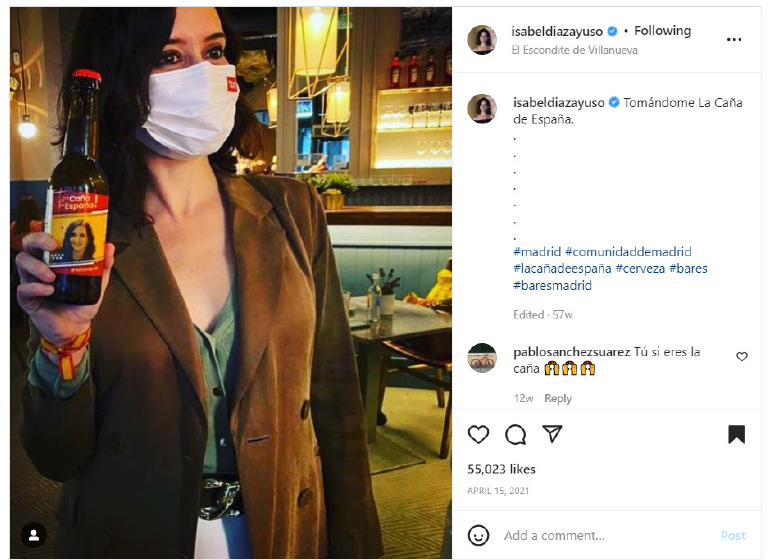
Figure 4. Díaz Ayuso holding a bottle with the flag of Spain and a picture of herself in the label on April 15, 2021. Media and Communication, 2022, Volume 10, Issue 4, Pages